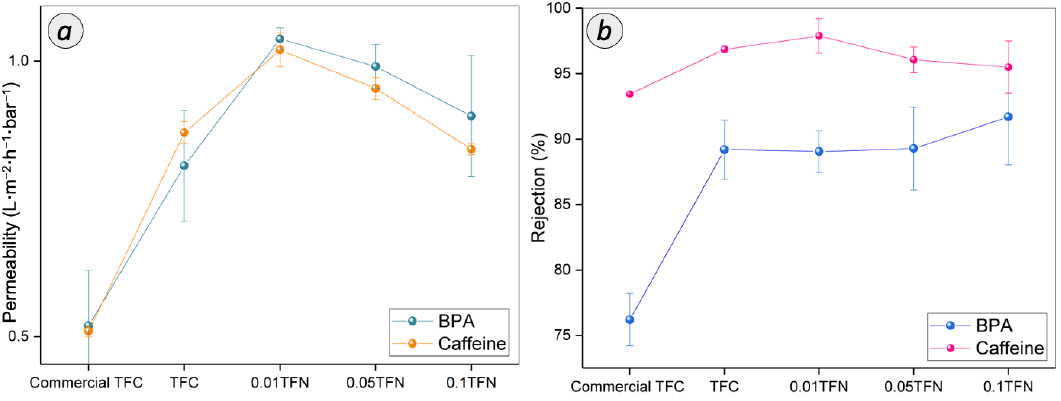
Figure 10. ( a ) Permeability and ( b ) rejection of TFC and TFN membranes for BPA and caffeine sep- aration.